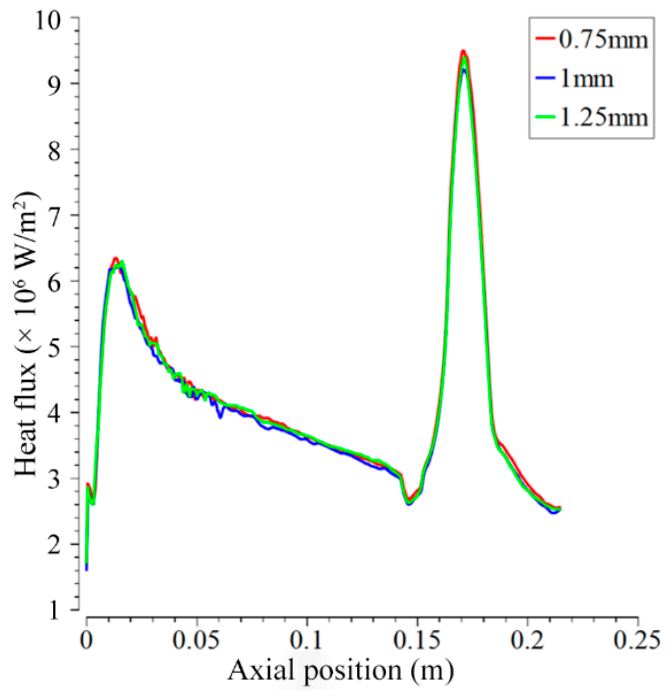
Figure 12. Heat flux curves for different rib height working conditions.